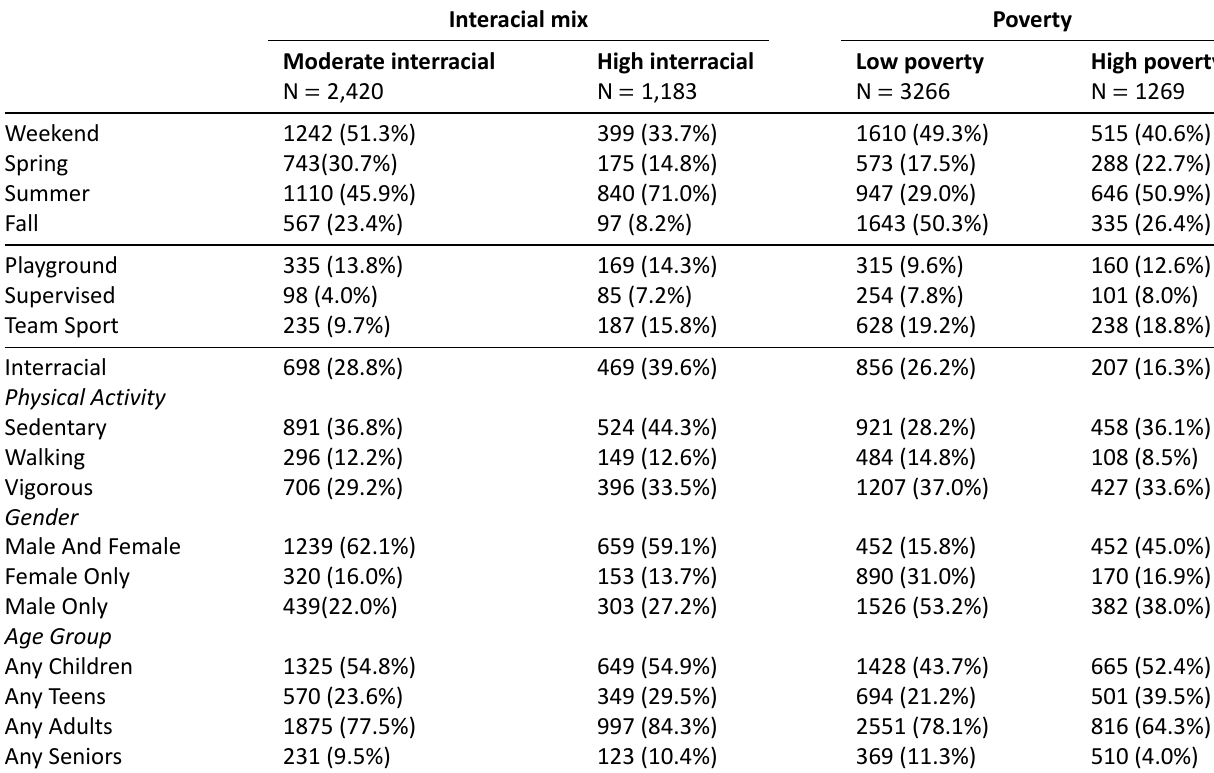
Table 2. Descriptive statistics by area racial/ethnic and income composition for sample of park